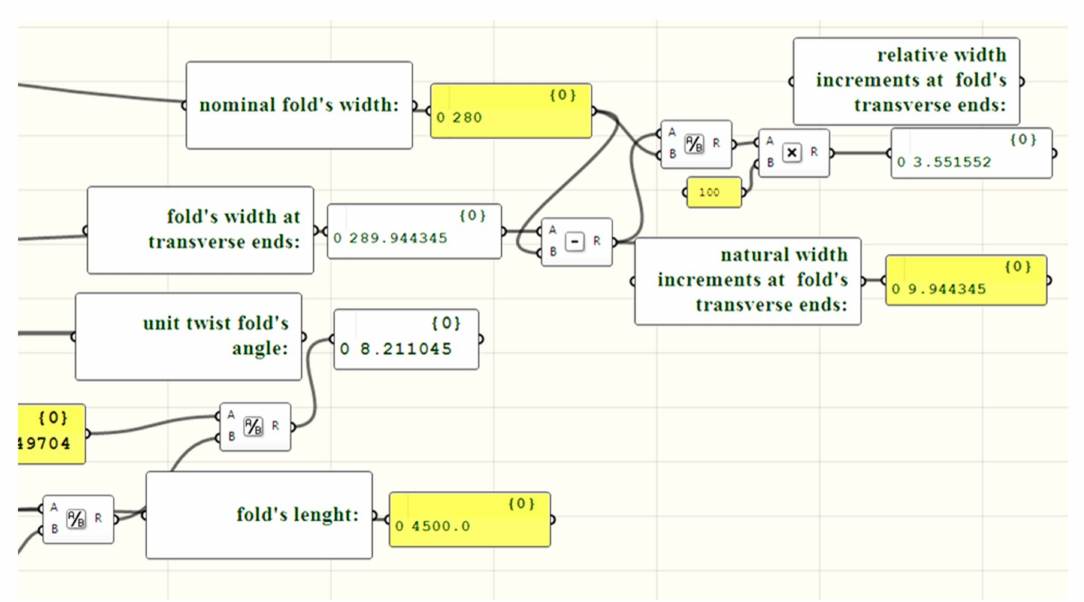
Figure 24. Important features of a simplified smooth shell model of the central fold of a shell, whose unit twisting angle α j is equal to 8.211045 ◦